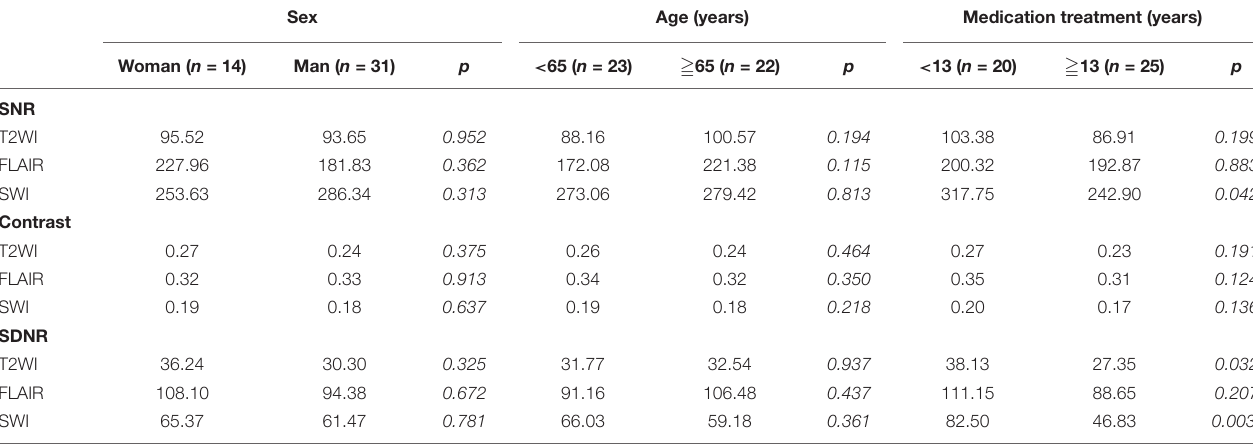
TABLE 4 | Subgroup comparison of SNR, contrast, and SDNR for STN in 45 patients with medication-refractory Parkinson’s disease. Sex Age (years) Medication treatment (years)